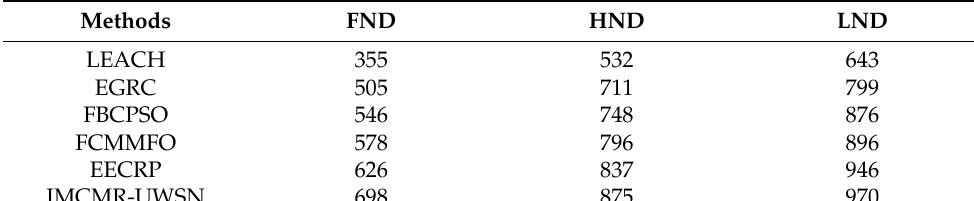
Table 2. Network lifetime analysis of the IMCMR-UWSN technique.